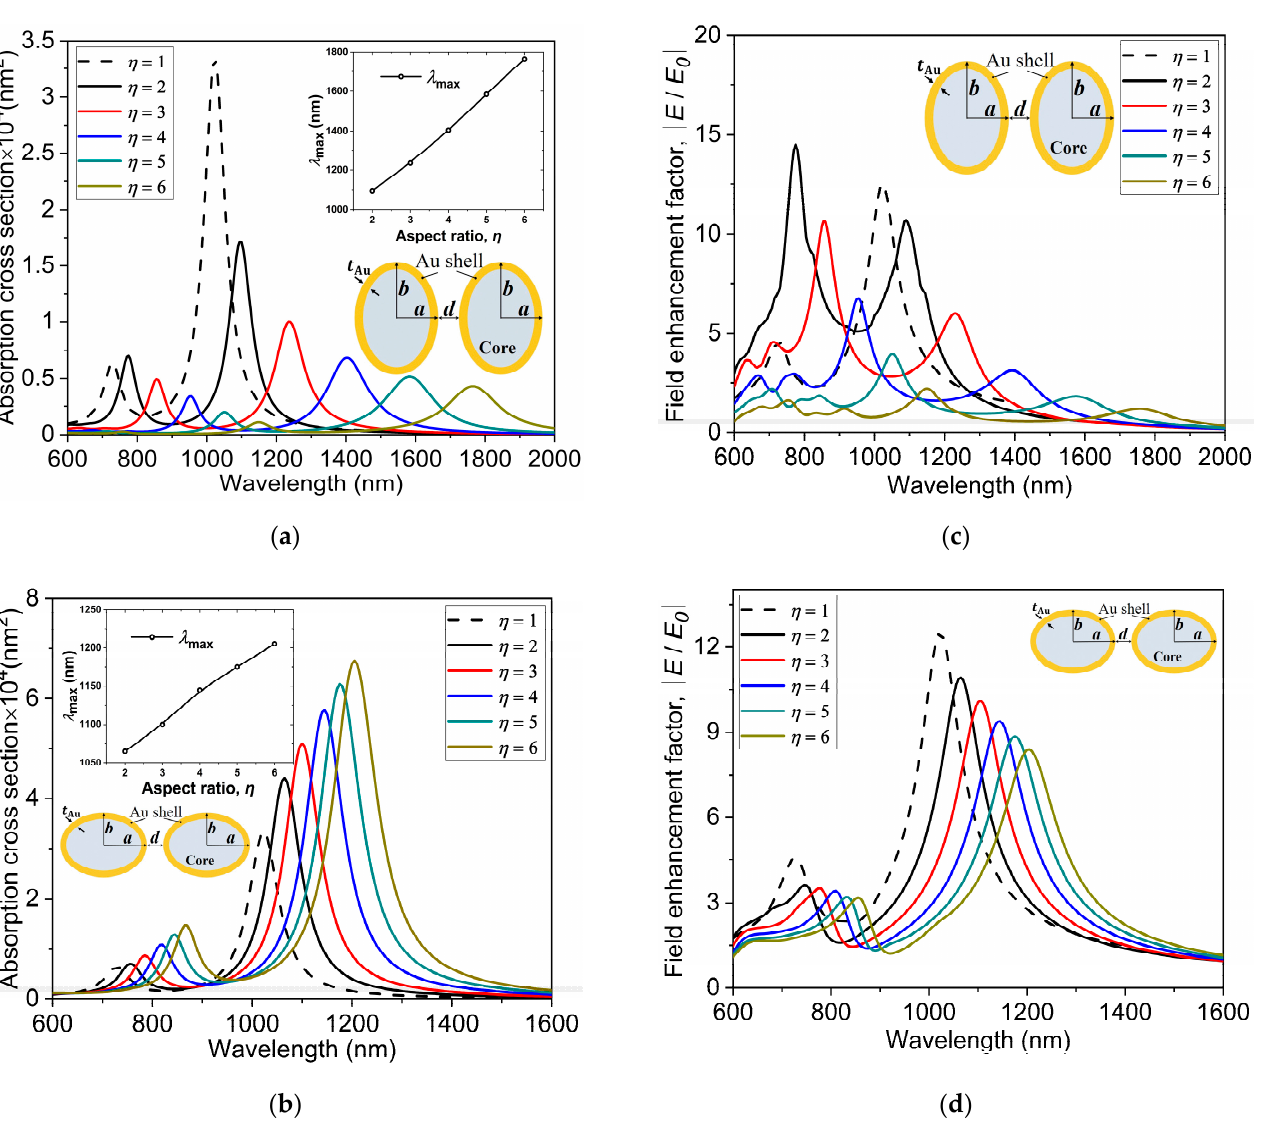
Figure 4. Absorption cross-sections at different aspect ratios for the ( a ) prolate and ( b ) oblate core-shell nanostructures (𝑟 (cid:2915)(cid:2916)(cid:2916) = 23 nm, 𝑛 = 1.33) . The insets in panels ( a ) and ( b ) show the dependence of the LSPR peak position ( λ max ) on the aspect ratio. The electric field enhancement | E / E 0 | at different aspect ratios for the ( c ) prolate and ( d ) oblate nanostructures. The absorption cross-sections and electric field enhancement for the spherical core-shell dimer nanostructures ( η = 1 ) are also shown for comparison (black dashed curves).